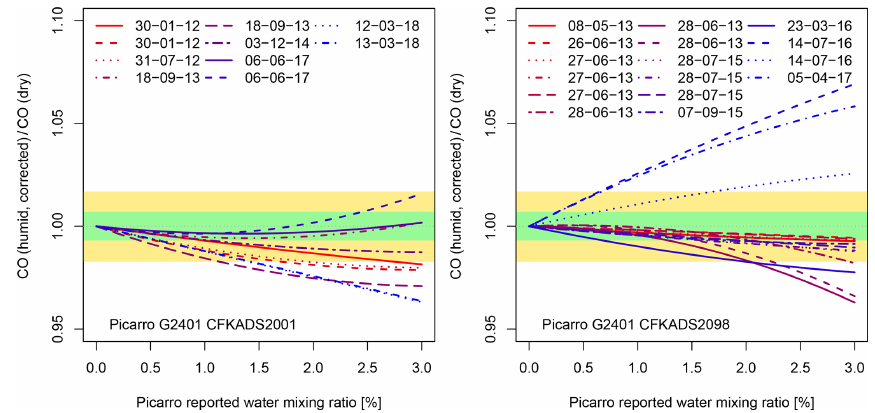
Figure 10. Ratios of CO (humid, corrected)/CO (dry) amount fractions vs. the water vapour mixing ratios of two different Picarro G2401 NIR-CRDS analysers over time. The legend shows the date (dd-mm-yy) of the experiment. The coloured areas are the lim- its for the WMO/GAW network compatibility goal (green) and extended (yellow) network compatibility goal at the amount fraction of 300nmolmol − 1 CO.